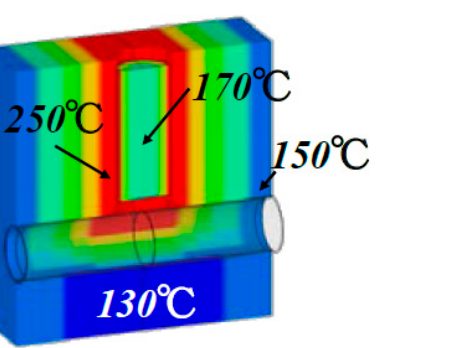
Figure 17. Optimum temperature conditions in T-shape forming for AZ31B magnesium alloy.